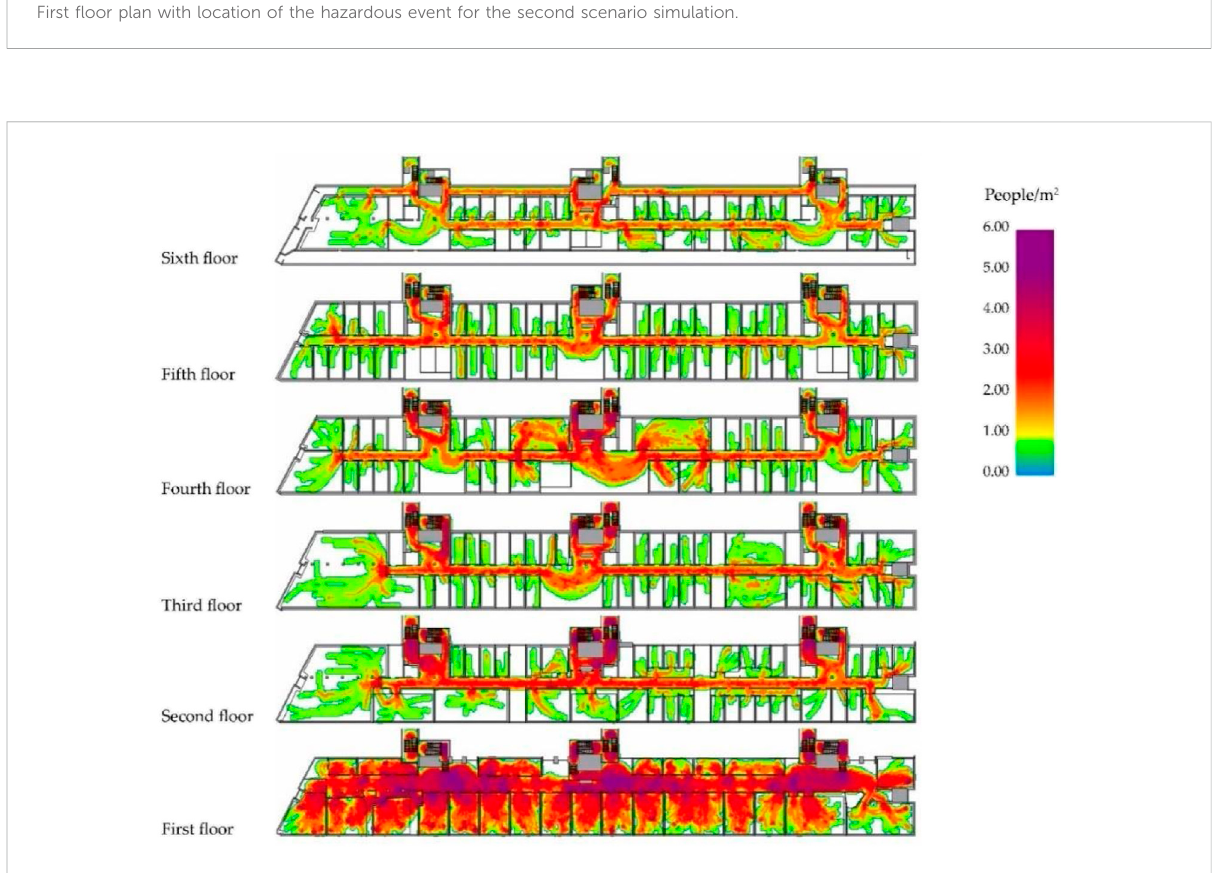
FIGURE 13 Density maps of crowd simulation of the fi rst